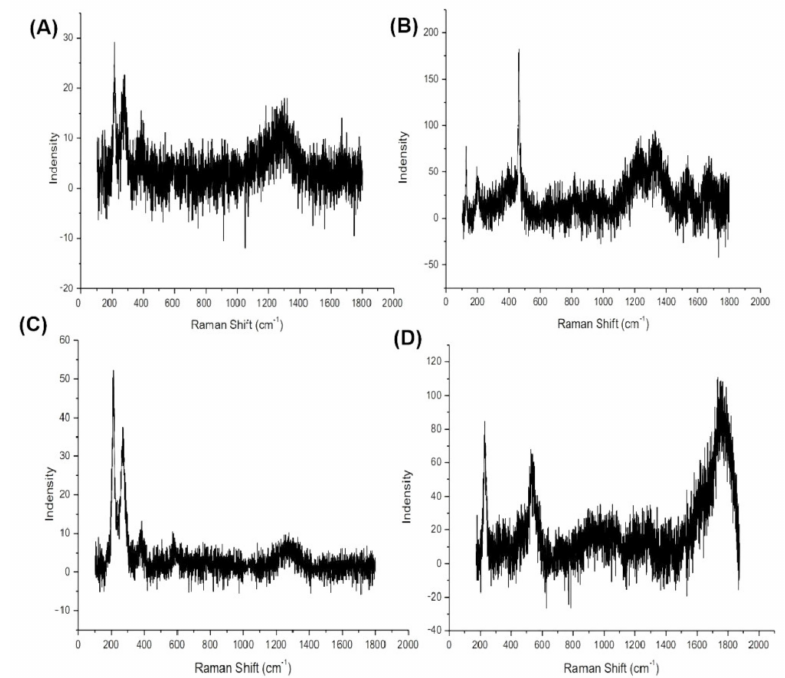
Figure 9. Raman spectrogram. ( A – D ) Raman maps of four sample.